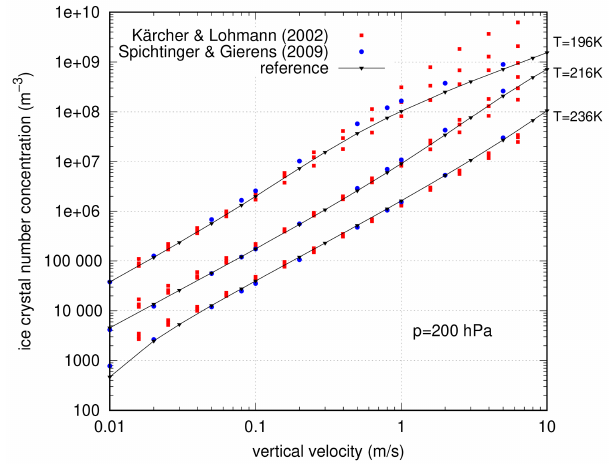
Figure B1. Comparison of ice crystal number concentrations as obtained for typical nucleation events from different models. Red squares – particle model by Kärcher and Lohmann (2002); blue circles – complex two moment bulk scheme by Spichtinger and Gierens (2009); and black line and triangles – simpler bulk model from this study, indicated as new